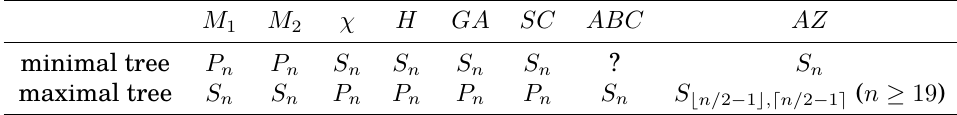
Table 2: Extremal trees for some graphical indices.